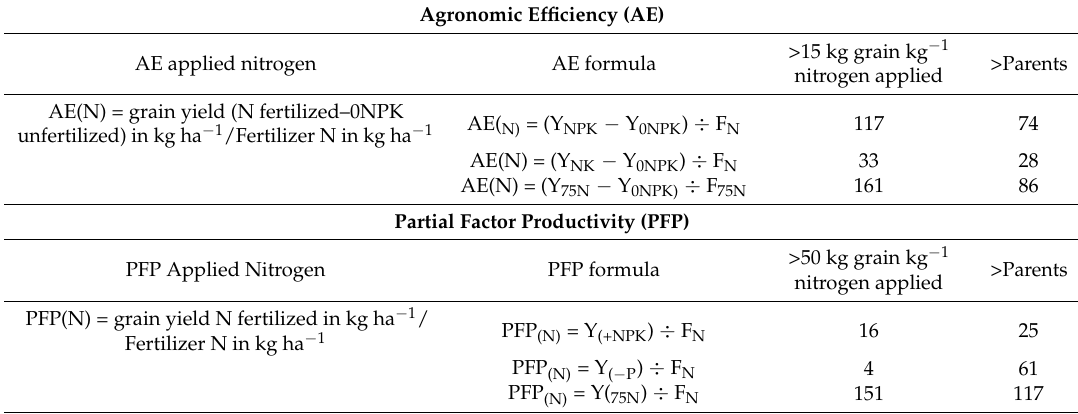
Table 4. Determination of NPK fertilizer efficiency in ILs under experiment on